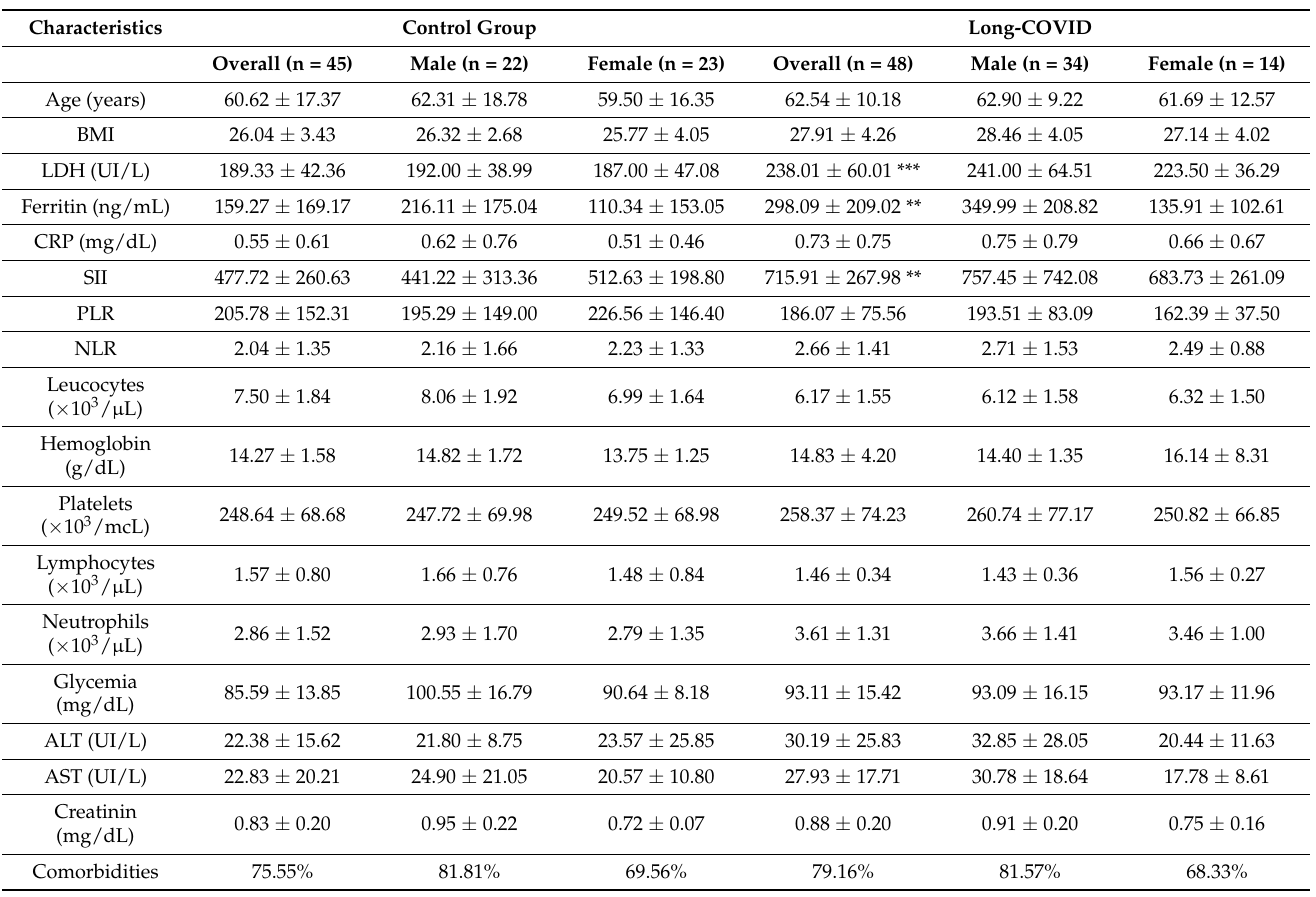
Table 1. Values are reported as mean values for the continuous variables and percentages for the categorical variables. Statistical significance was assessed by p value ( p ) thresholds: ** p < 0.01; *** p < 0.001 ( t -test